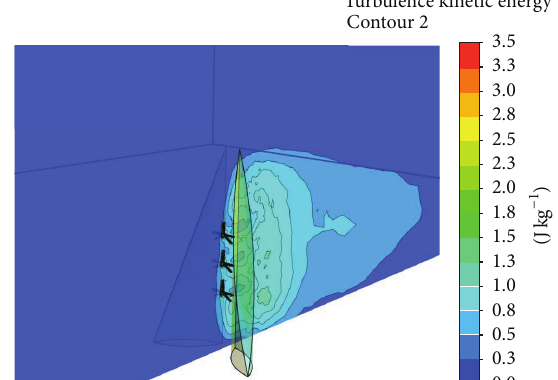
Figure 9: Contour levels of static pressure on the surface of the building and ground.